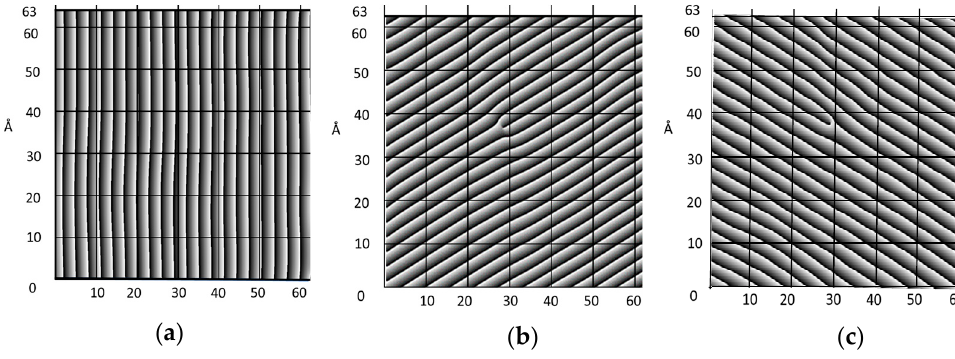
Figure 10. Wrapped phases of fringes corresponding to crystal structure: ( a ) e 1 ; ( b ) e 2 ; ( c ) e 3 .